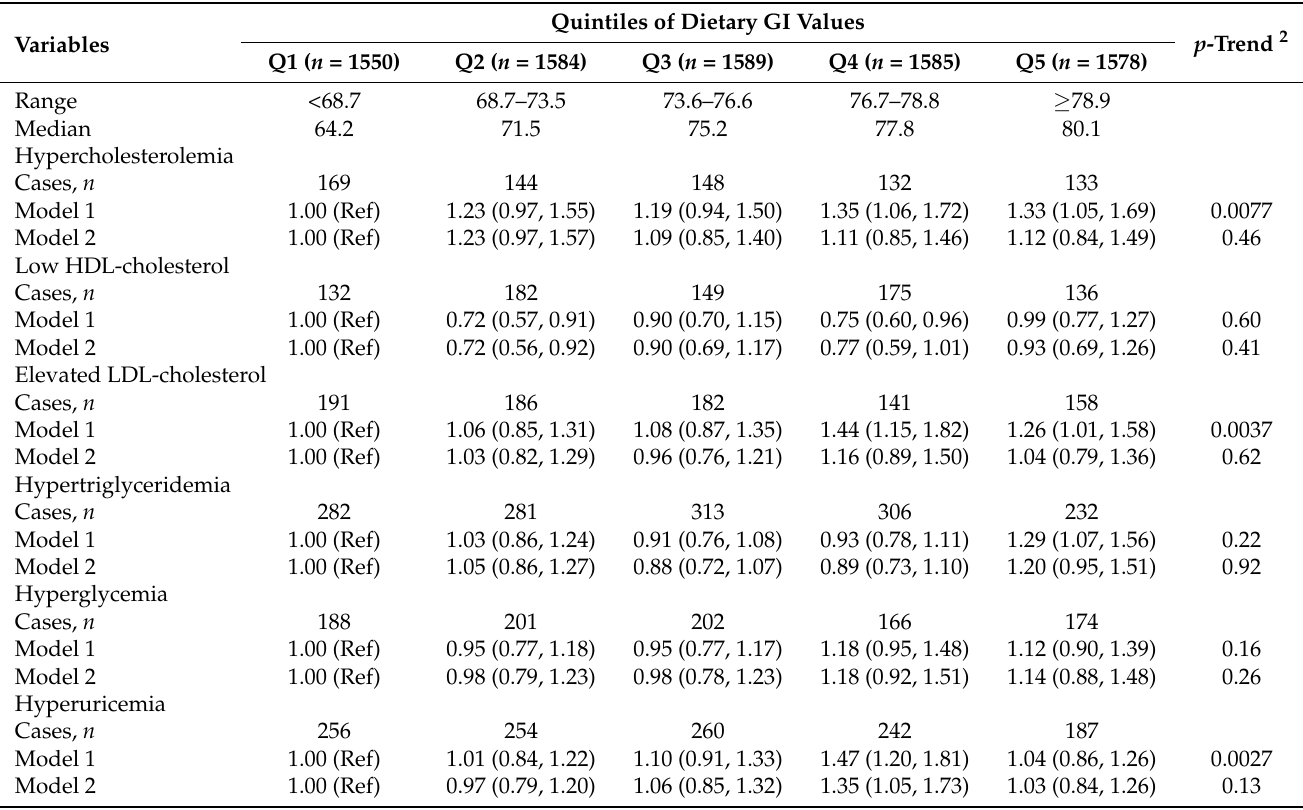
Table 2. The associations between quintiles of dietary GI values and cardiometabolic risk factors of 7886 Chinese adults who participated in the China Health and Nutrition Survey 2009 ( N = 7886) 1